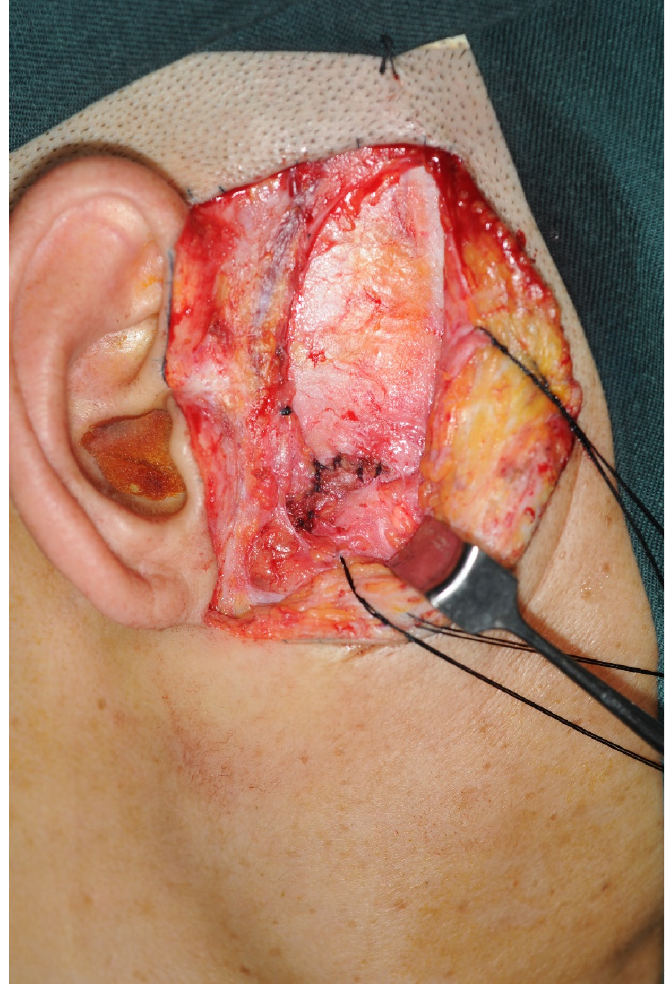
Figure 1. The superficial layer of deep temporal fascia was revealed. A “T”-shaped incision was performed outside the joint capsule to open it. The joint disc was found at the posterior slope of the articular eminence and was attached before electrocoagulation separation and cutting. The joint anchor nail was implanted 0.5 cm be- low the posterior slope of the condylar process to cover the joint disc at the top of the condylar process. The joint disc was then fixed with the anchor nail (Figure 2). Bipolar electrocoagulation was sufficient to stop bleeding, and a 100 mL negative pressure drain- age tube was placed in the layer-by-layer suture wound (Figure 3). The postoperative rou- tine included the use of antibiotics and steroids to prevent infection and reduce swelling. Antibiotics: Cefuroxime sodium 1500 mg + 0.9% saline solution 250 mL, intravenous drip, bid, three days. Steroids: Dexamethasone 10 mg + 5% glucose injection 250 mL, intrave- nous drip, qd, three days. In addition, physiotherapy of two weeks in duration was sug- gested.